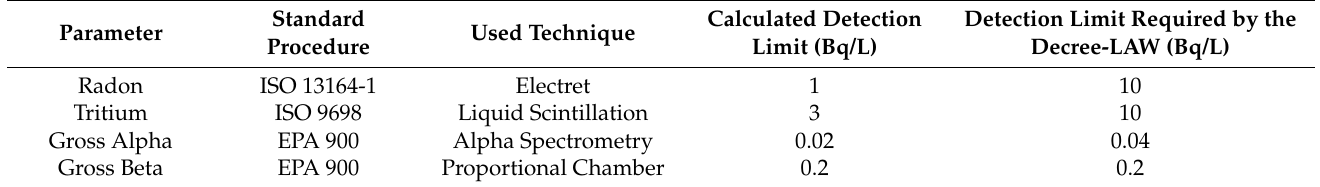
Table 1. Minimum Detectable Activity (MDA) for each parameter, reference norm, and technique reported in reference [36].